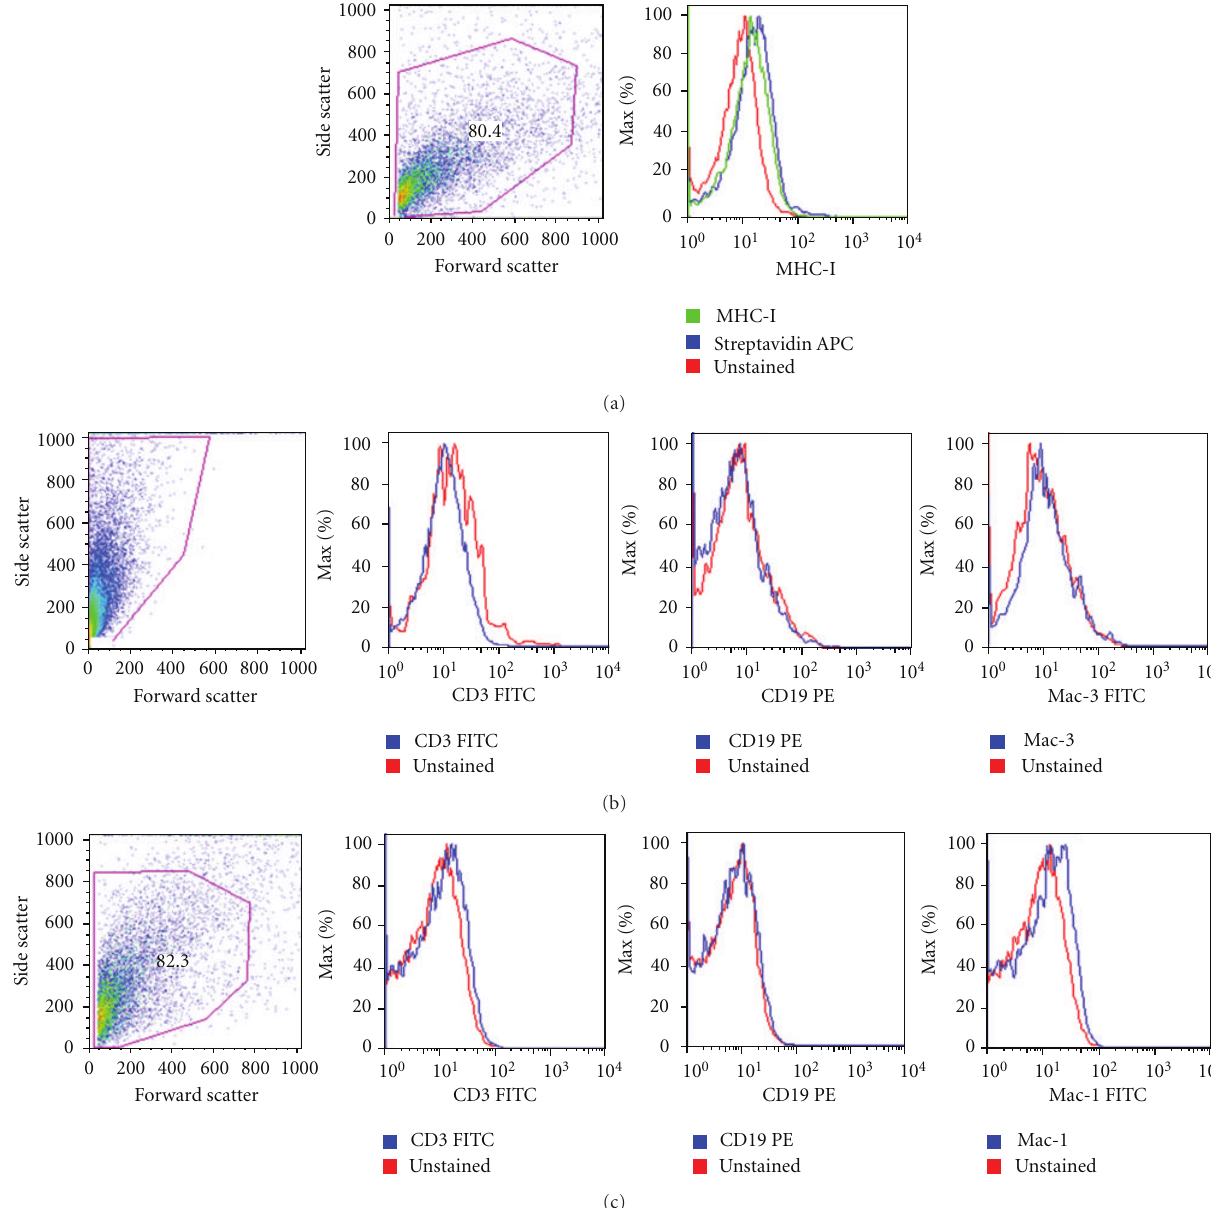
Figure 4: Non-host-contaminated parasite isolated cells. Cells from (a) T. solium cells, (b) T. crassiceps cells, and (c) T. spiralis cells were disaggregated by tissue disruption and stained with anti-hMHC-I, anti-mCD3, anti-mCD19, anti-mCD11b, and anti-mMac-3 antibodies.